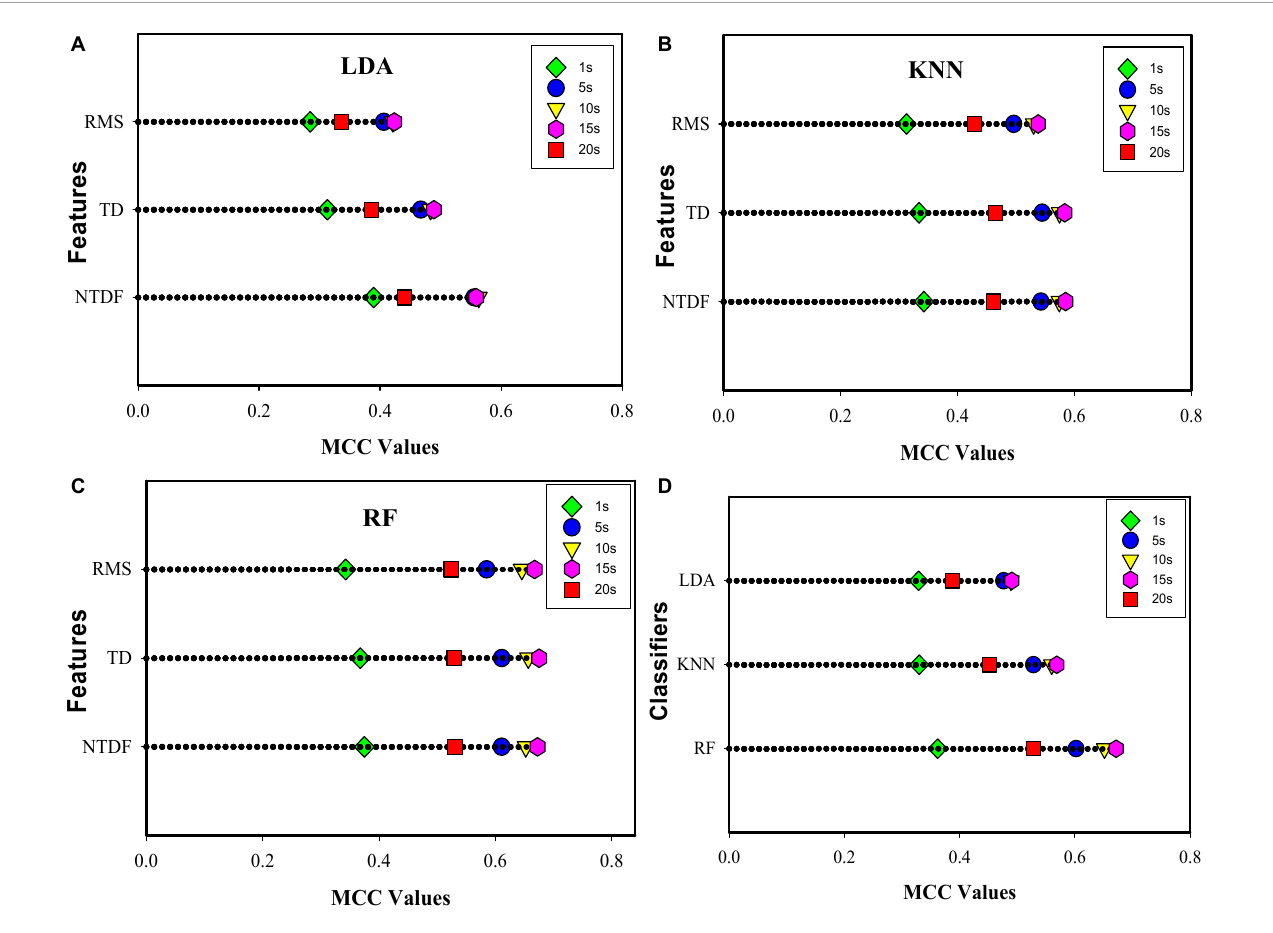
FIGURE5 Average MCC values of the motion duration groups across finger gestures and participants based on Between-SRD Strategy using NTDF, TD4, and RMS for (A) LDA, (B) KNN, and (C) RF, (D) average MCC value using all the features, for LDA, KNN, and RF